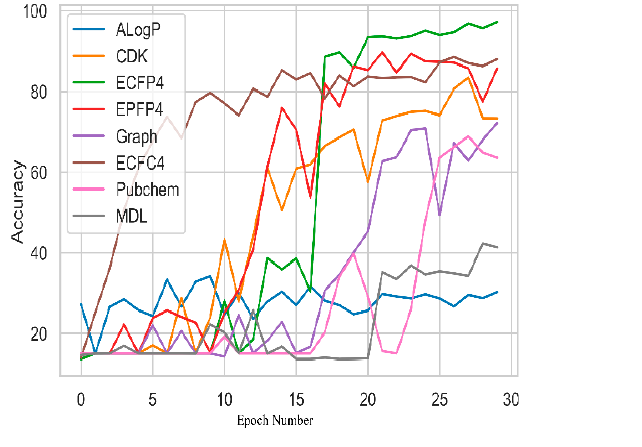
Figure 3. Evaluation of eight fingerprints based on their ( a ) accuracy and ( b ) MSE performance.